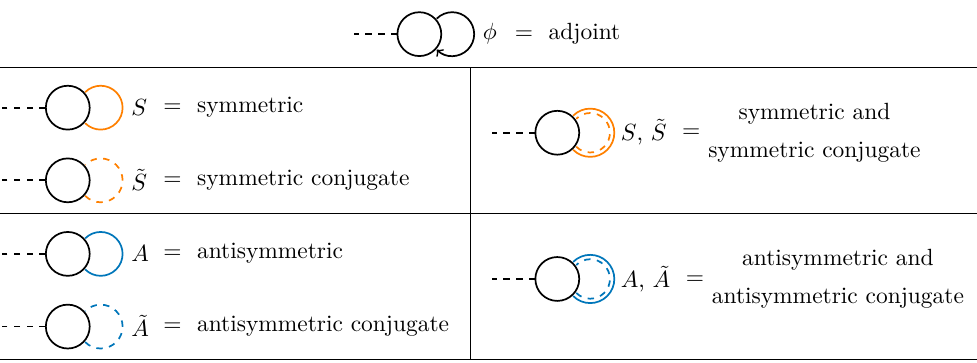
Table 1 . Conventions for representing tensorial matter in quiver diagrams. When there are two possible representations for a tensorial field (e.g. the antisymmetric representation for an orthogonal gauge group) we choose to represent it as an